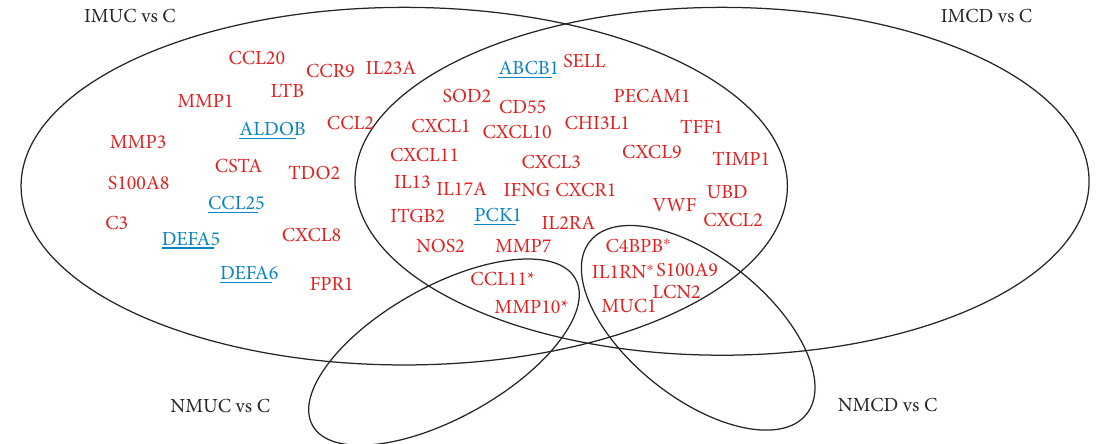
Figure 1: Venn diagram showing the genes di ff erentially expressed across the performed di ff erent comparisons with controls. Genes marked with asterisk ( ∗ ) are di ff erentially expressed in the paired IM-NM analysis. IM=in fl amed mucosa; NM=nonin fl amed mucosa.